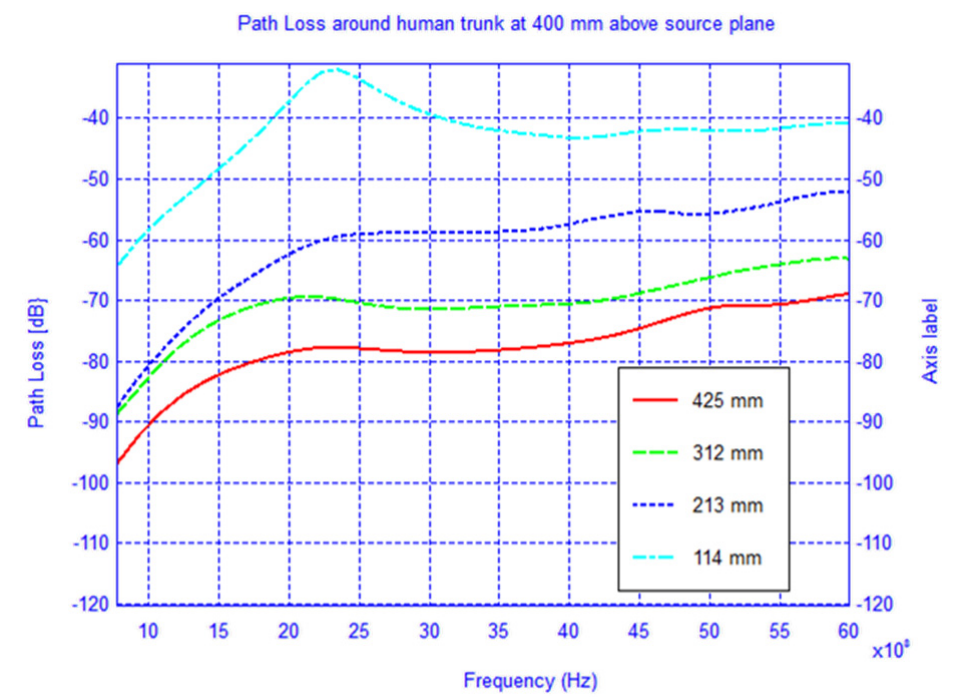
Figure 4. Path loss around the cylindrical human trunk model 400 mm above source